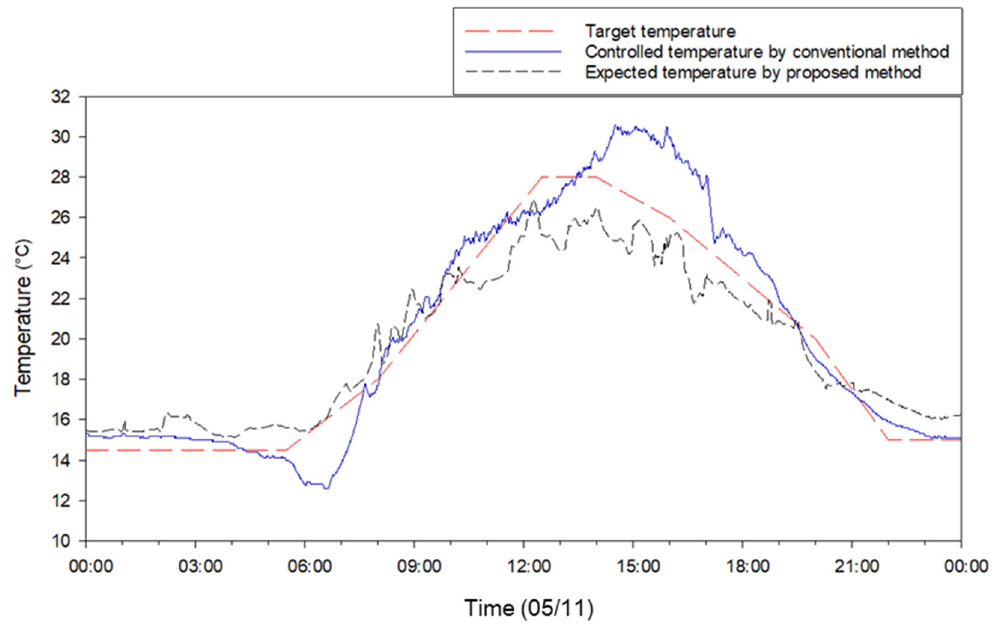
Figure 9. Comparison of temperature control performance between the proposed method and the conventional controller on 11 May.